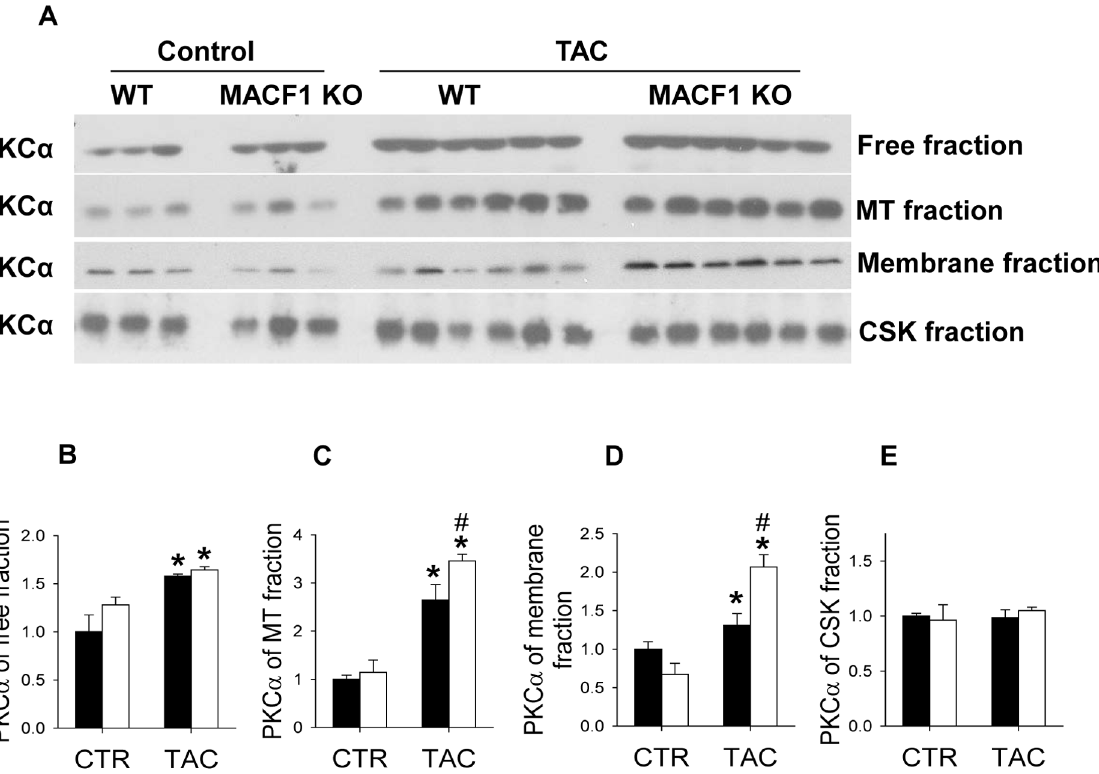
Figure 7. MACF1 KO increases membrane abundance of PKC a . Western blot analysis of PKC a in subcellular fractions of ventricular lysates from WT and MACF1 KO hearts ( Figure 7A–E ). (* indicates p , .05 as compared to control conditions, # indicates p , .05 as compared to WT under same conditions, n=4 to 6 per condition; n=4–6 per group.)